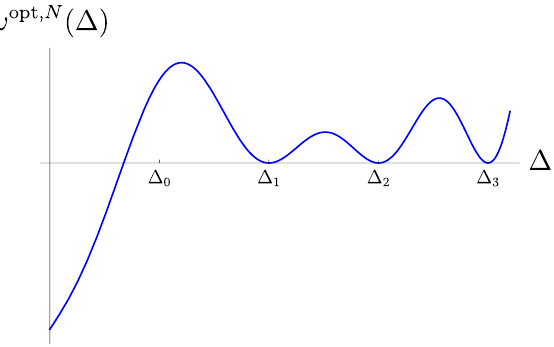
Figure 1 . Schematic form of the optimal functional. Such a functional provides a valid upper bound on the OPE coe(cid:14)cient at (cid:1)